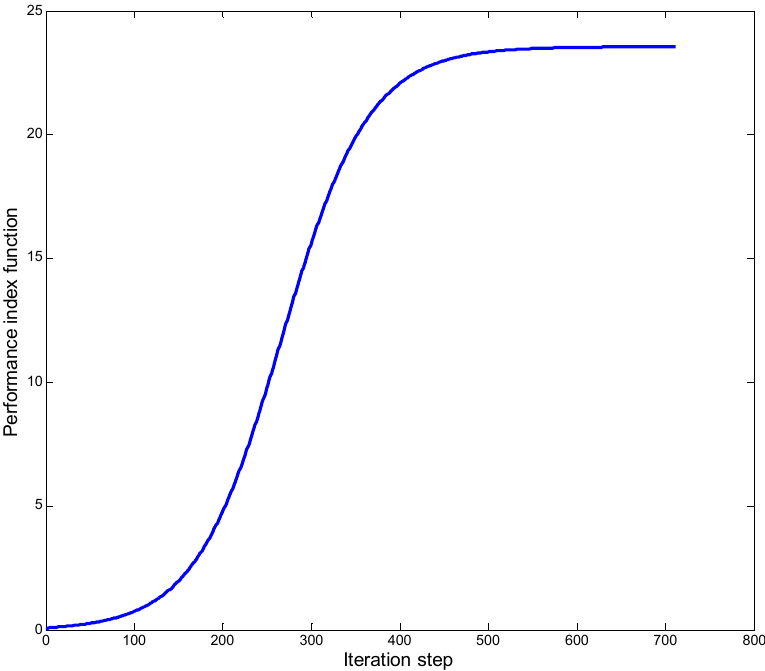
Figure 4. The changes of performance indexes with the iterations.